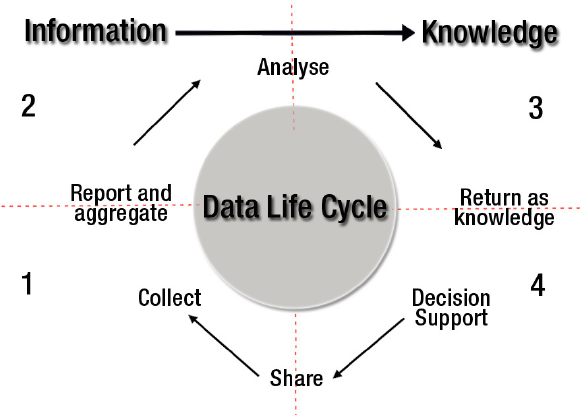
Figure 1: Data Life Cycle in the aspect of transform information to knowledge (According to R. Piechowski, 2010) The most important issue is how we exploit these geospatial big data (Lee and Kang,